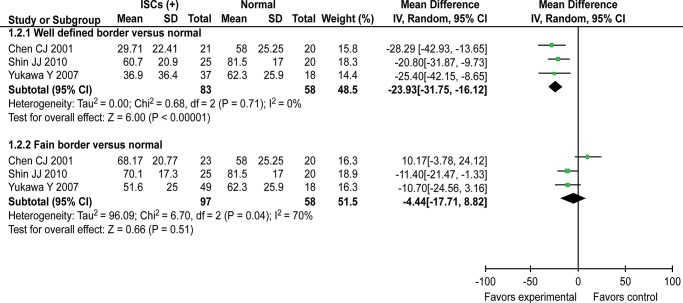
The forest plot of the faint, well-defined border group versus the normal group.